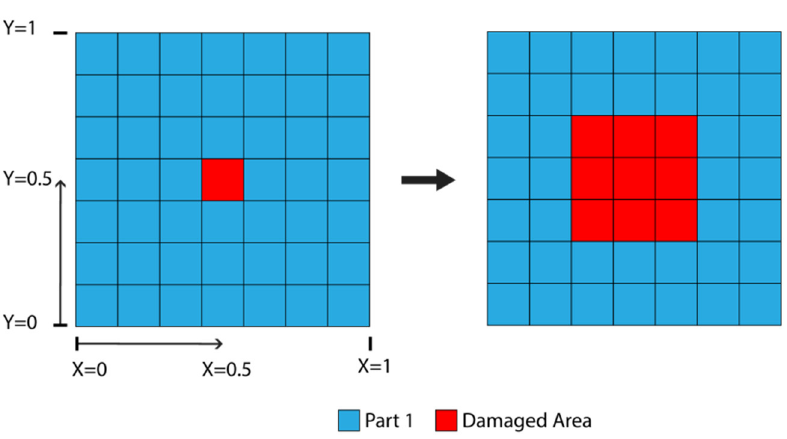
Figure 2. Expansion of the damaged area.